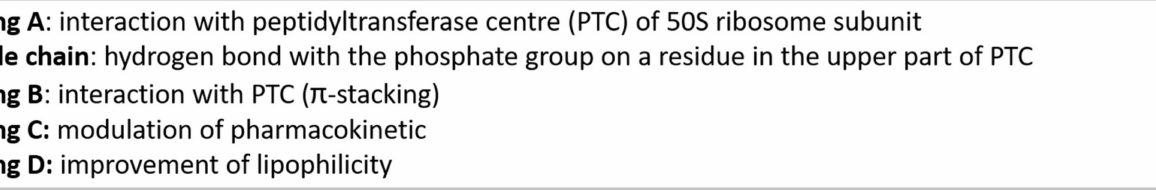
Figure 1. Core structure of oxazolidinone antibiotics and molecular structures of main derivatives (Linezolid, Sutezolid, Eperezolid, Delpazolid, Tedizolid, Tedizolid phosphate, Radezolid and TBI-223). Brief description of chemical groups required for the binding to peptidyltransferase center (PTC) and chemical groups that improve the